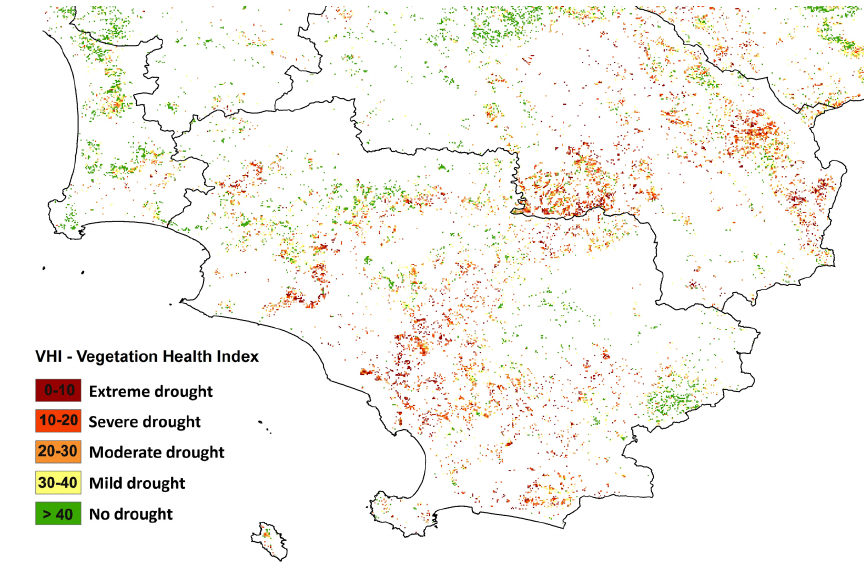
Figure 10. Zoom of vineyard and olive grove areas particularly affected by the 2016–2017 drought event (VHI-Vegetation Health Index map related to the 16–31 October 2017 period).